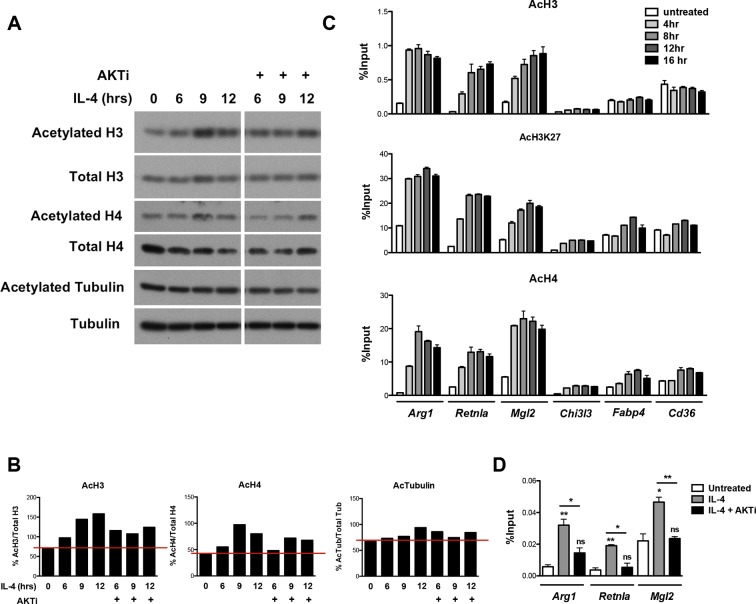
Akt regulates inducible histone acetylation at some M2 genes. (A) IL-4 increases global histone acetylation in an Akt-dependent manner. BMDMs stimulated as indicated were analyzed by western blotting for H3 and H4 acetylation. (B) Quantitation of the western blotting data in A. (C) IL-4 induces an increase in H3, H3K27, and H4 acetylation at promoters of M2 genes. BMDMs were stimulated with IL-4 over the time course indicated, followed by ChIP analysis to examine H3, H3K27, and H4 acetylation at M2 gene promoters. (D) Akt regulates Pol II recruitment at some M2 genes. BMDMs stimulated for 16 hr with IL-4 +/- Akt inhibitor pretreatment were subject to ChIP analysis using antibodies to Pol II. Enrichment of the indicated M2 gene promoters was assessed by qRT-PCR. The student’s t-test was used to determine statistical significance, defined as *P<0.05, **P<0.01, and ***P<0.001.